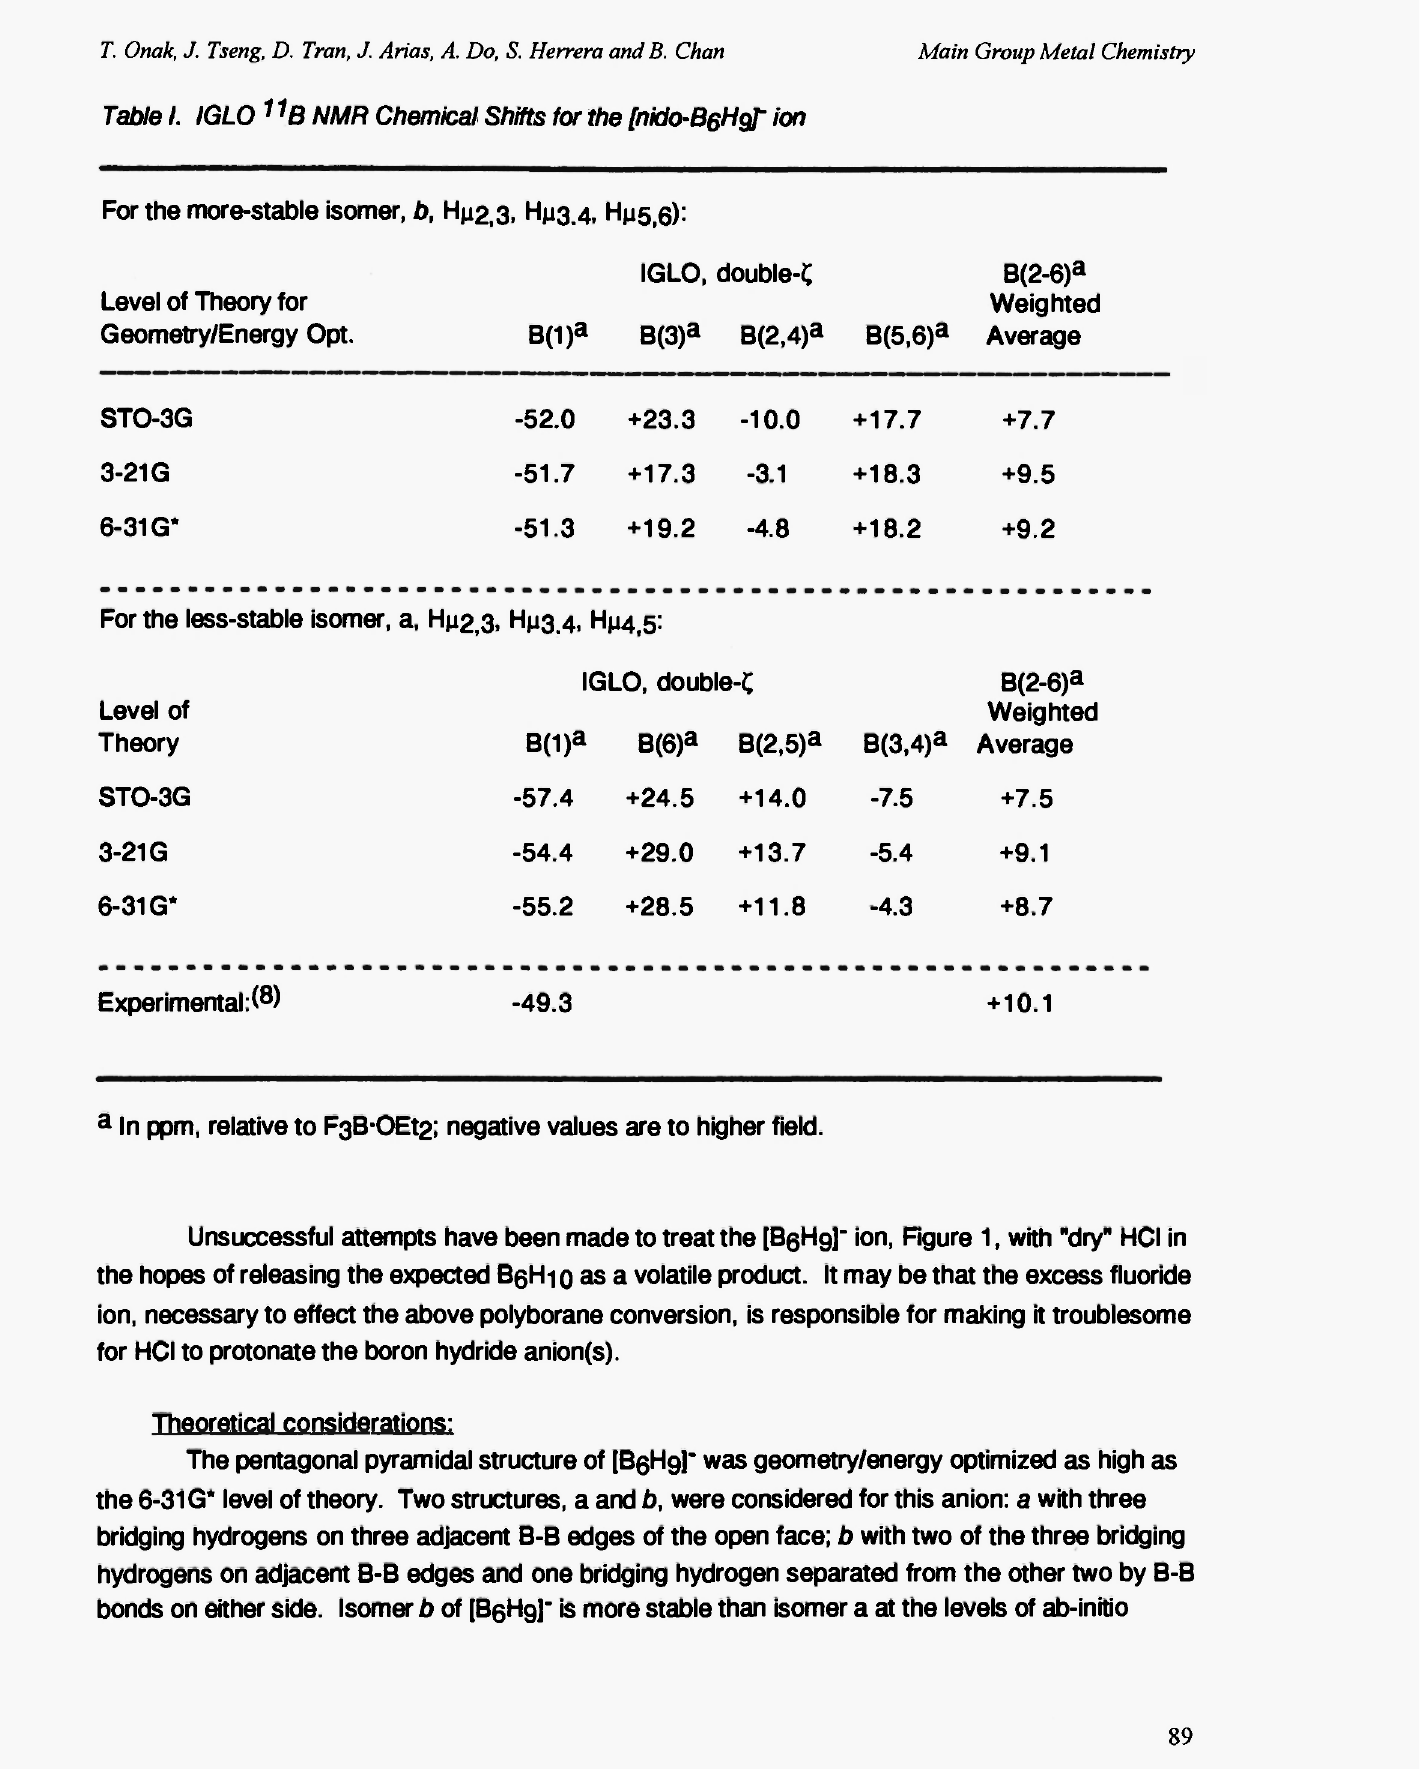
Table I. IGLO 11 B NMR Chemical Shifts for the [mdo-BßHgT ion